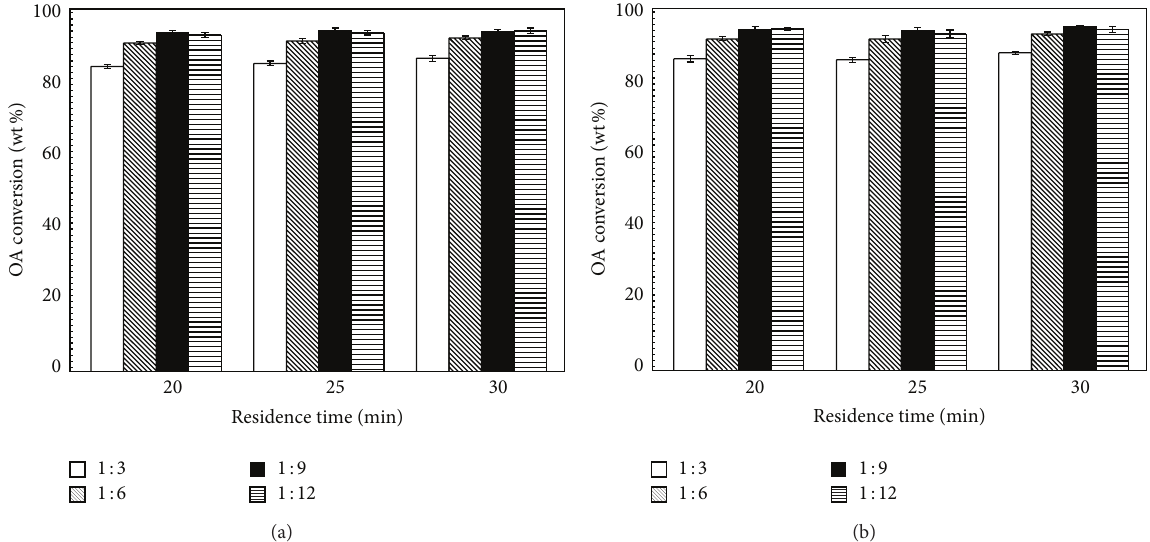
Figure 1: Effect of molar ratio on the conversion of oleic acid to pressure 20 MPa and temperature: 573 K (a) and 598 K (b).